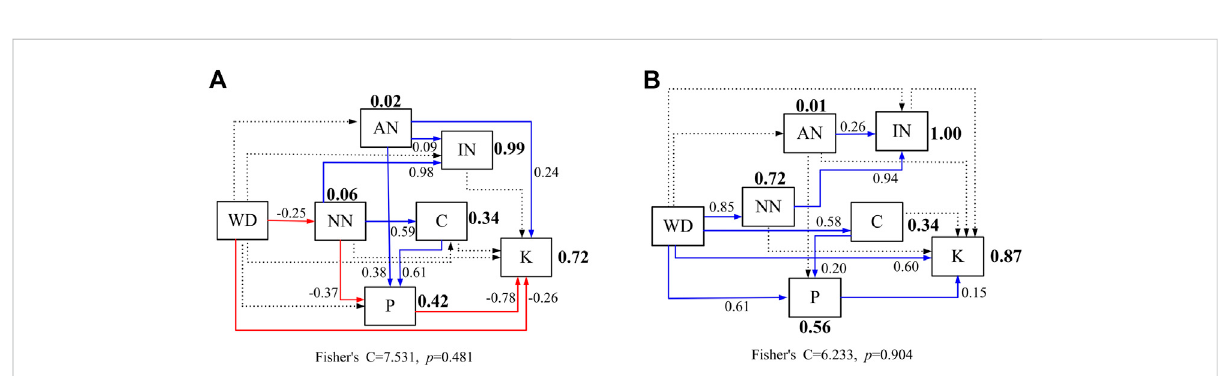
FIGURE 4 Controlling factor analysis of soil nutrients using the structural equation model. Solid lines indicate signi fi cant regressions ( p < 0.05) and no signi fi cant regressions by dashed lines. Blue arrows denote positive relationships, and red arrows denote negative ones. Abbreviations of variables: WD, groundwater depth; C, soil organic carbon; NN, soil nitrate-N; AN, soil ammonium-N; IN, soil inorganic-N; P, soil available phosphorus; K, soil available potassium. (A) Relationships between groundwater depth and soil nutrients in the shallow groundwater; (B) Relationships between groundwater depth and soil nutrients in the deep natural